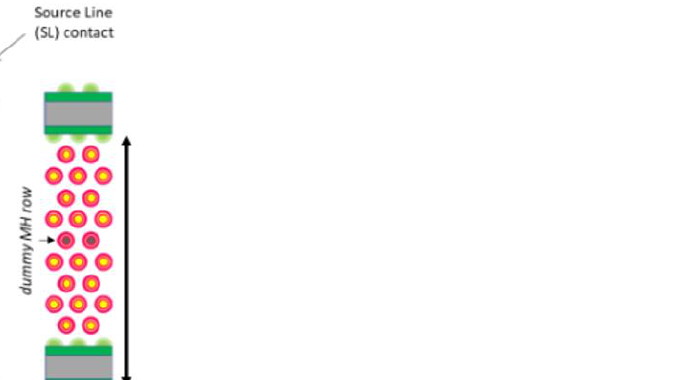
Figure 13. Charge-trap cell with the confined SiN storage layer and the process flow. The SiN storage is successfully sep- arated between cells. The pillar etching diameter needs to be smaller compared to the conventional charge-trap cell. Re- printed with permission from ref. [44], Copyright 2019 IEEE. 5. 3D NAND Array Logical Scaling by Cell Device Engineering In addition to the physical cell density scaling, the logical density scaling (i.e., more bits per cell scaling) has been actively pursued in 3D NAND. Figure 14 shows the number of 3D NAND publications in ISSCC conferences. 3D NAND started as MLC technology and rapidly transitioned to TLC, owing to the excellent cell characteristics and reliability. Recently, QLC technology has been introduced to mass production and the presence of the QLC technology has also been increasing in the pub- lications. Currently, TLC is the mainstream for high-performance and high-endurance us- ages. QLC is becoming mainstream for the high-density and low-cost usages. Recently, “beyond QLC” efforts have been reported for both FG and charge-trap cells. PLC (5 bits per cell) distributions were shown with FG cells (Figure 15a) [45]. In this